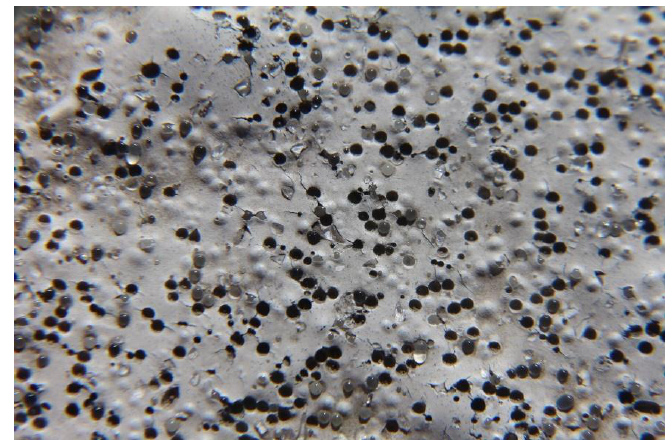
Figure 13. S18 sample in situ detail after 12 months of service. Emergence of glass microbeads from the bottom layer is observed.